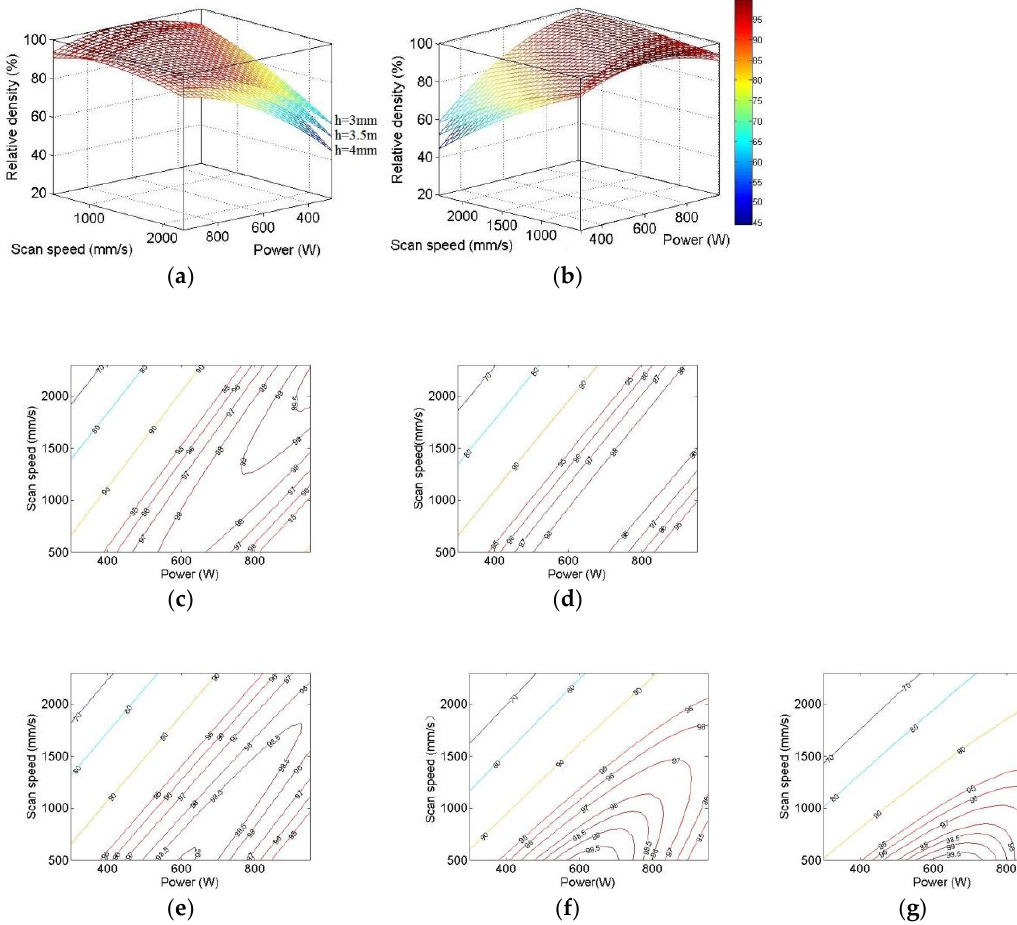
Figure 5. The relationship of relative density with power and scan speed for the regression model using the suggested Archimedes method for measurement of relative density. ( a ) and ( b ) Response surfaces; ( c ) contour: h = 0.275 mm; ( d ) contour: h =0.29mm; ( e ) contour: h = 0.3 mm; ( f ) contour: h = 0.35 mm; and ( g ) contour: h = 0.4 mm.